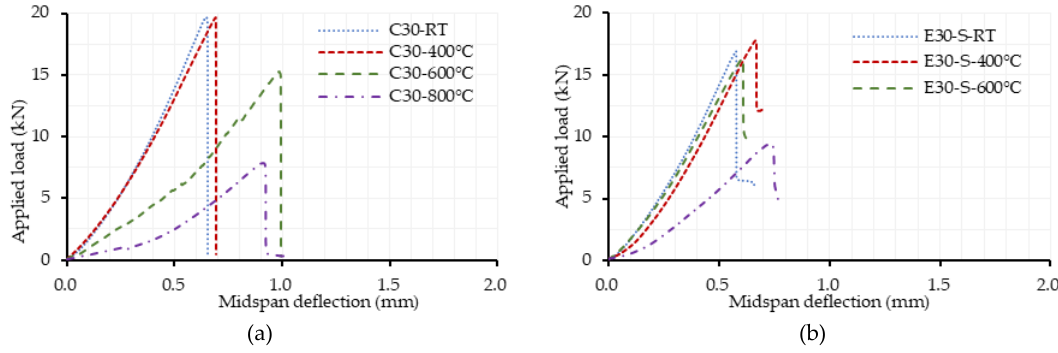
Figure 12. Load–deflection curves of low-strength LWC specimens: ( a ) control group C30 and ( b ) experimental group E30-S.